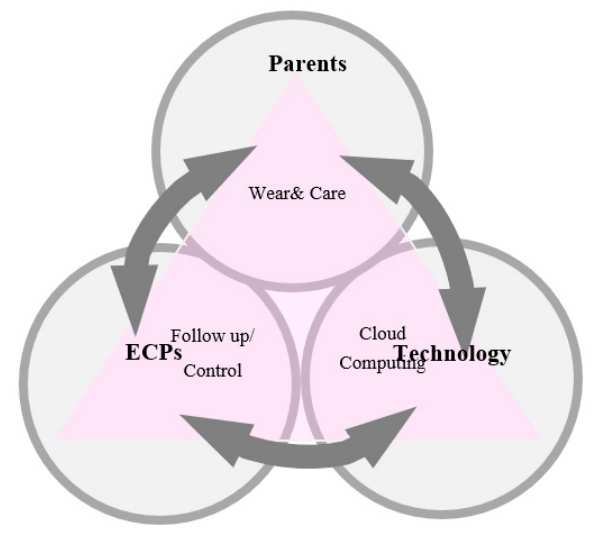
Figure 1. The workflow of orthokeratology compliance management. Note: ECPs—eye care pro-